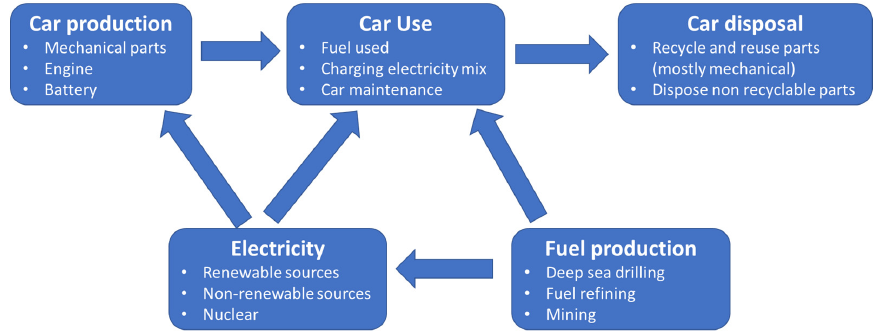
Figure 7. Sources of emission in life cycle of a car.